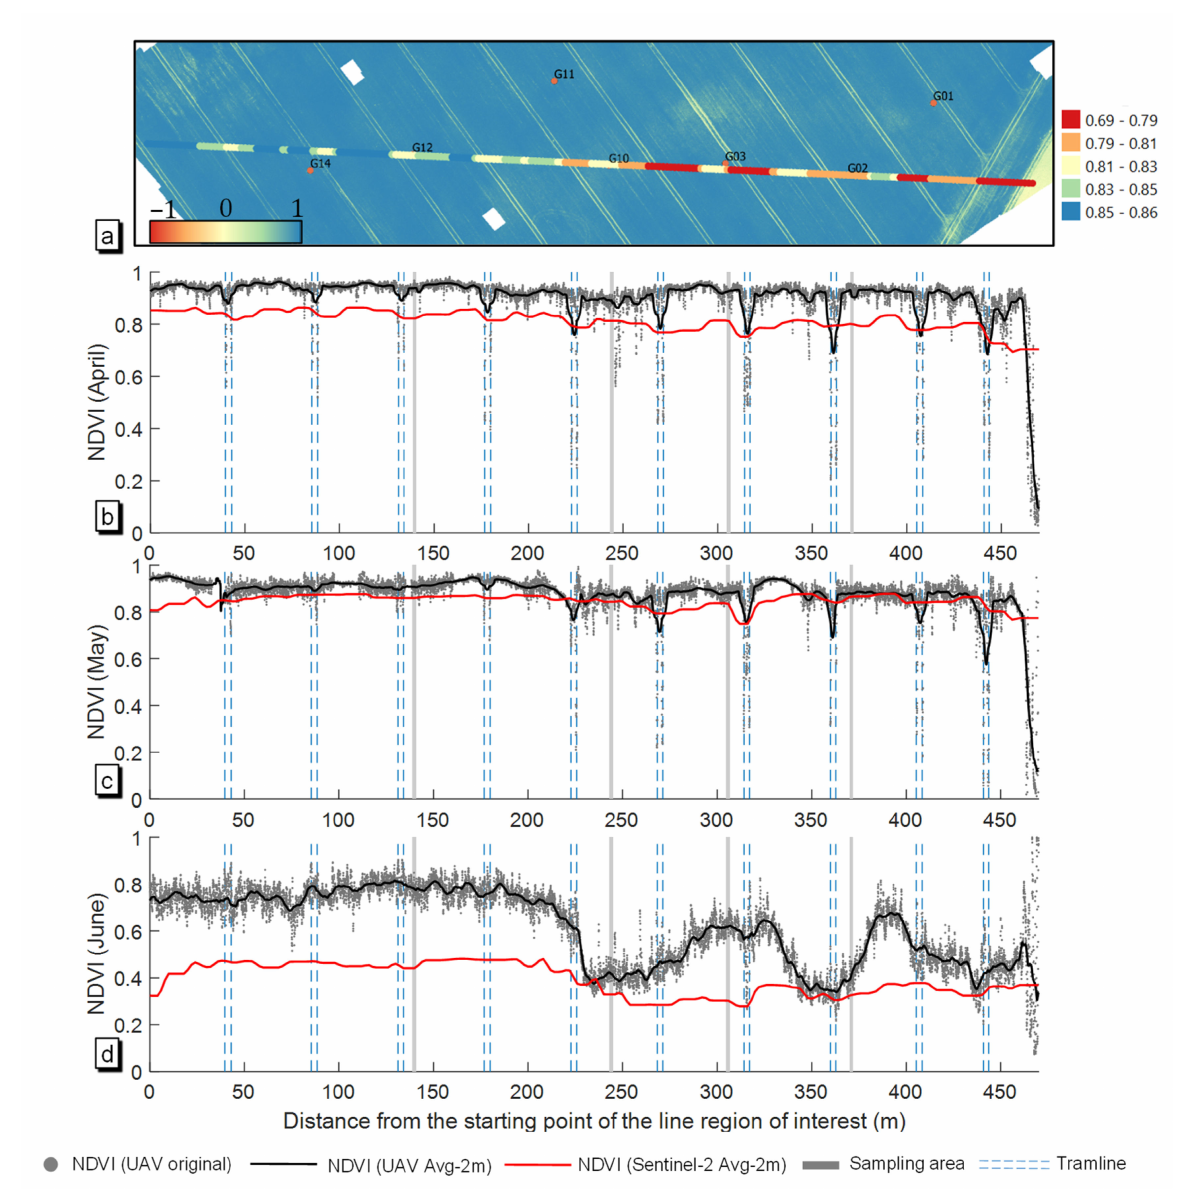
Figure 12. Comparison of NDVI values between UAV imagery and Sentinel-2 data based on moving averages (2 m buffer size) extracted along a 470 m transect line within field G. ( a ) Transect line showing the Sentinel-2 averages superimposing the UAV image from April. In the diagrams ( b – d ), the moving average values from the UAV (black lines) and the Sentinel-2 image (red lines) are superimposing the NDVI values from UAV imagery in original resolution (grey dots) from April, May to